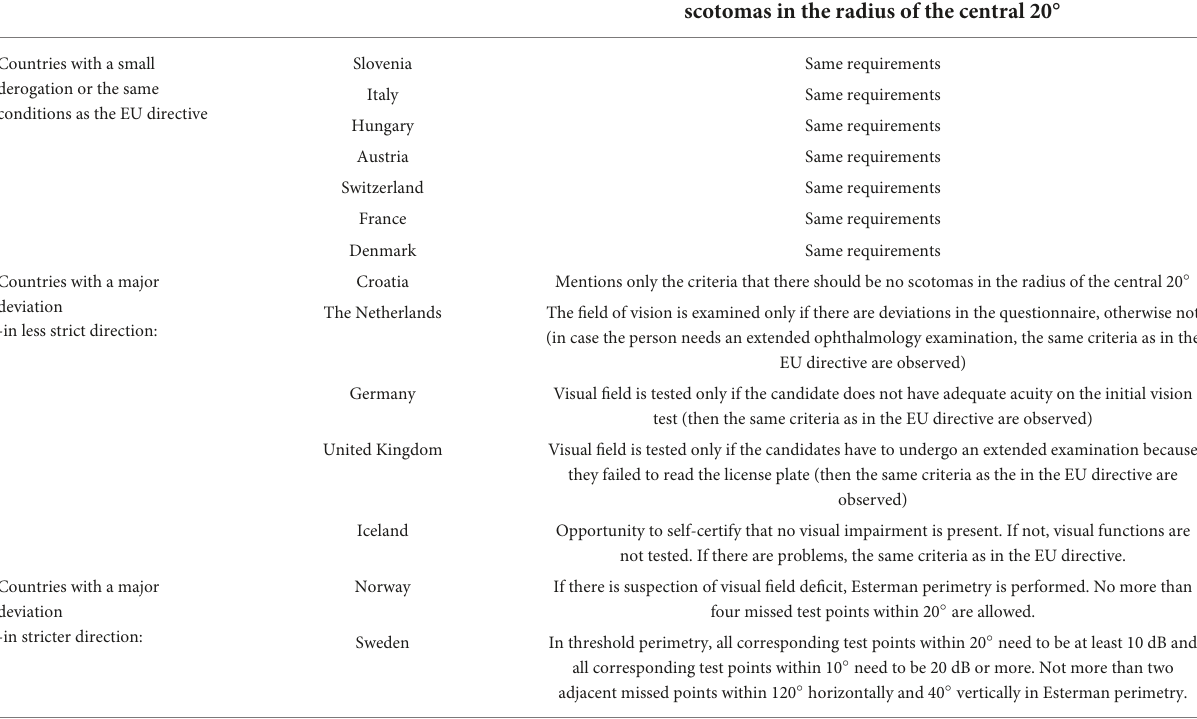
TABLE 2 European Union directive visual field requirements and comparison of the requirements among selected European countries according to the degree of deviation. EU directive Horizon at a visual field of at least 120 ◦ , the extension must be at least (2006/123/EC) 50 ◦ to the left and right and 20 ◦ up and down. There must be no scotomas in the radius of the central 20